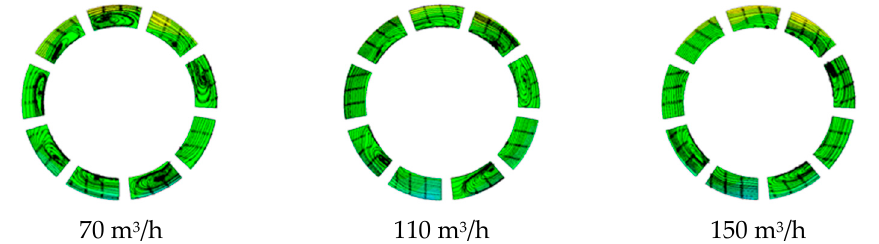
Figure 14. The streamline distribution of the middle section of the outlet section of the first impel- ler wheel.